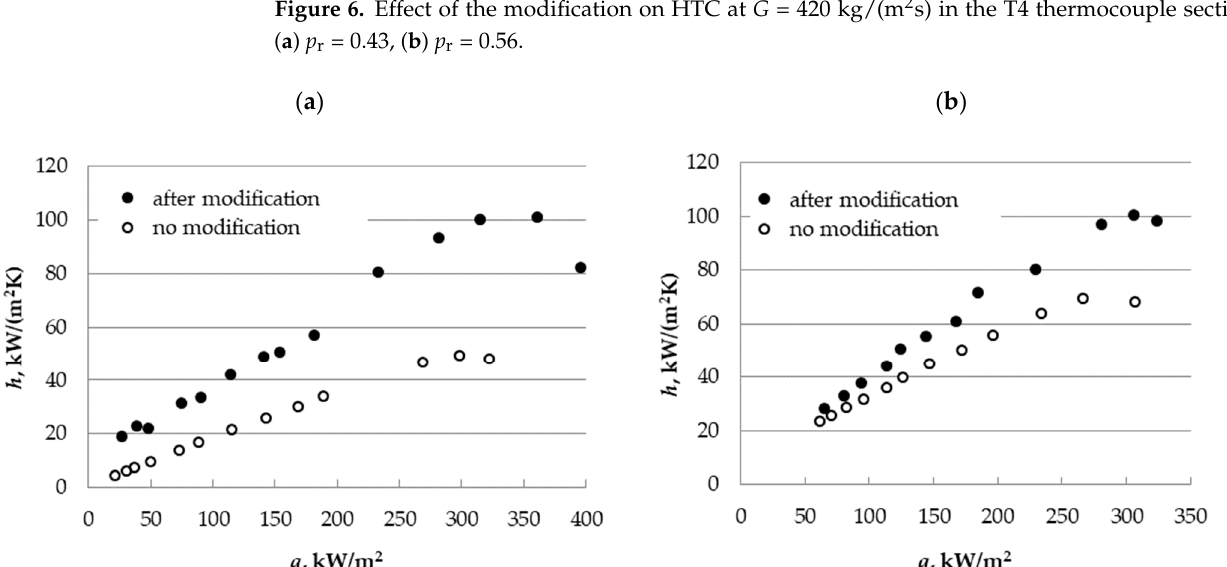
Figure 7. Effect of the modification on HTC at G = 800 kg/(m 2 s) in the T4 thermocouple section, ( a ) p r = 0.43, ( b ) p r = 0.56.